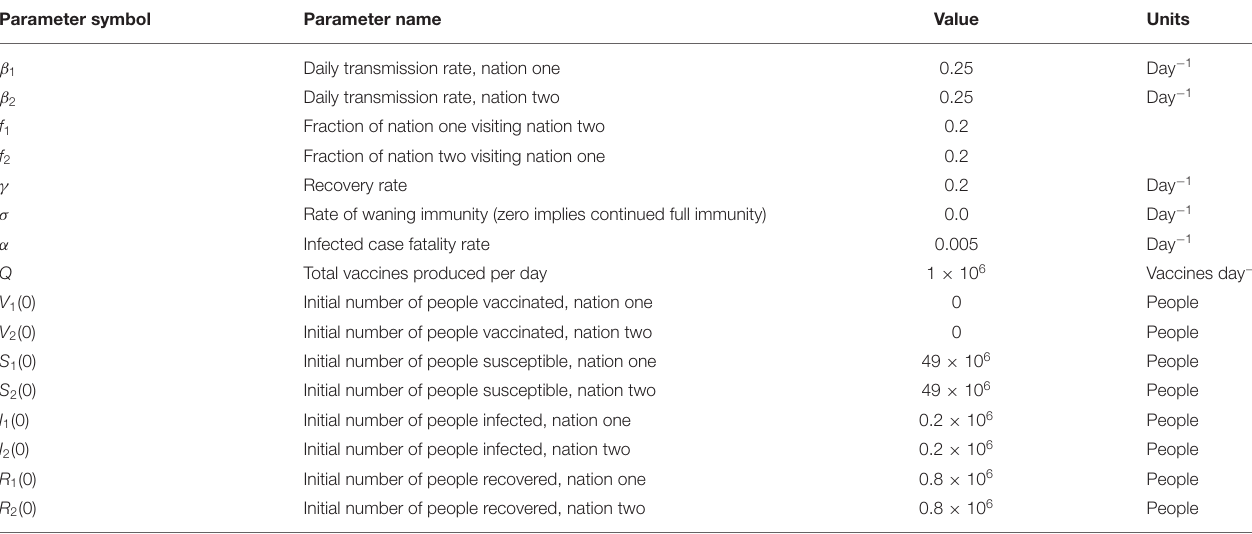
TABLE 1 | Parameters and initial conditions used for our governing Equations (1)–(4) and (7)–(10), and in Figure 1 . Parameter